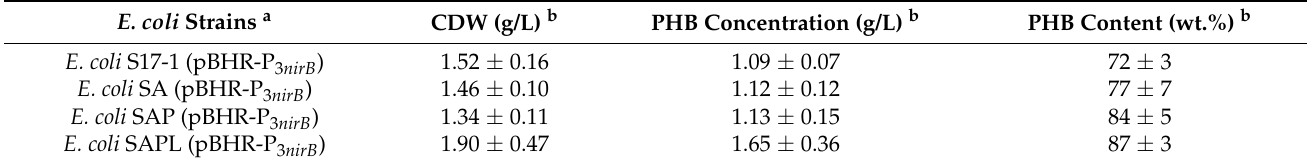
Table 2. Bacterial growth and PHB production by different E. coli strains harboring pBHR-P 3nirB under an anaerobic